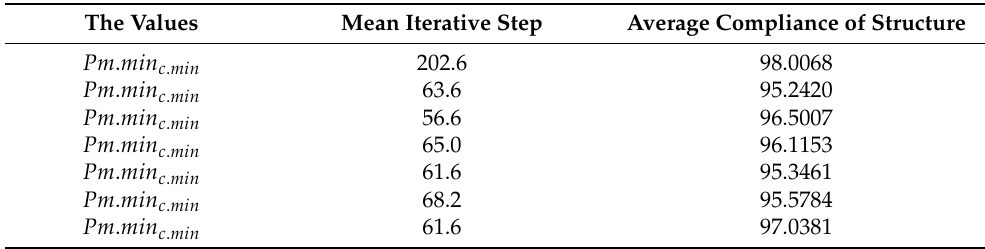
Table 1. The SA-BESO algorithm for the Michell-type structure—the optimization result data. The Values Mean Iterative Step Average Compliance of Structure